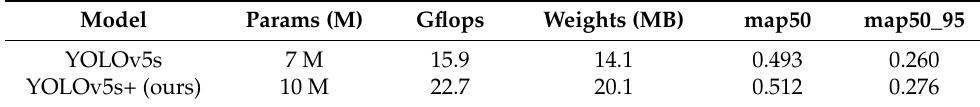
Table 1. Test of improved YOLOv5s on bdd100k